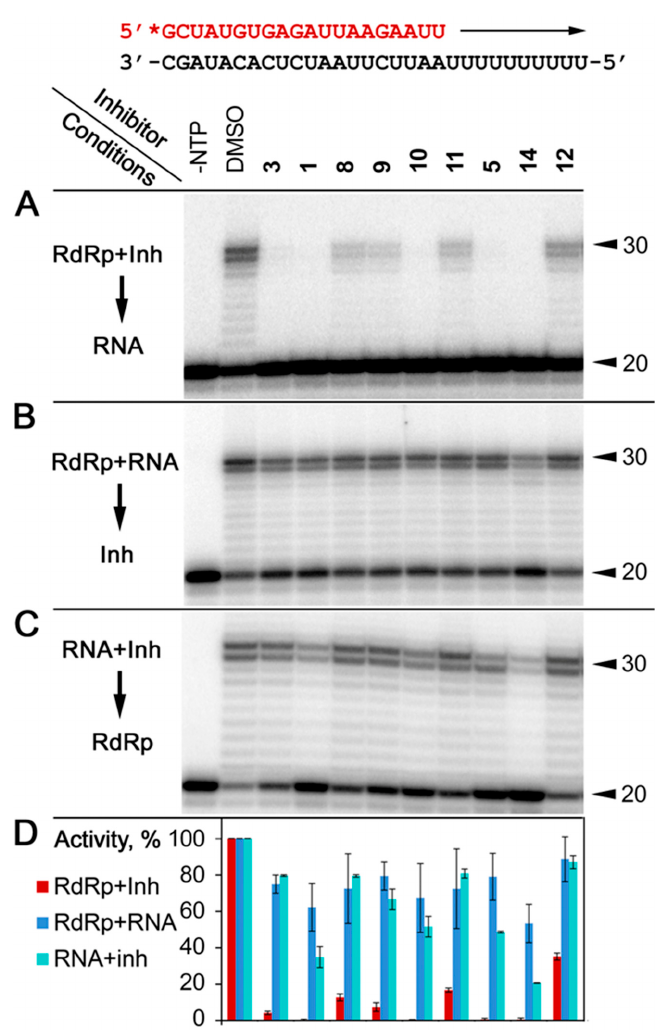
Figure 3. Inhibition of RdRp activity by the tested compounds. The primer–template RNA substrate (P 32 -labeled at the 5 ′ -end of the primer strand) is shown on the top. The assays were performed with different orders of the addition of the reaction components. ( A ) RdRp was first pre-incubated with indicated inhibitors and then the RNA substrate was added. ( B ) RdRp was mixed with the RNA substrate and inhibitors were added. ( C ) RNA was first pre-incubated with inhibitors and then RdRp was added. The final concentrations of RdRp, RNA, and inhibitors in all assays were 1 μ M, 25 nM, and 1 mM, respectively. DMSO was added in control reactions in the absence of inhibitors. ATP was added to 100 μ M and the reactions were performed for 1 min at 30 ° C. Positions of the starting 20 nt RNA primer and the extended full-length 30 nt RNA product are indicated. ( D ) Quan- tification of the inhibition efficiencies (averages from two independent measurements).